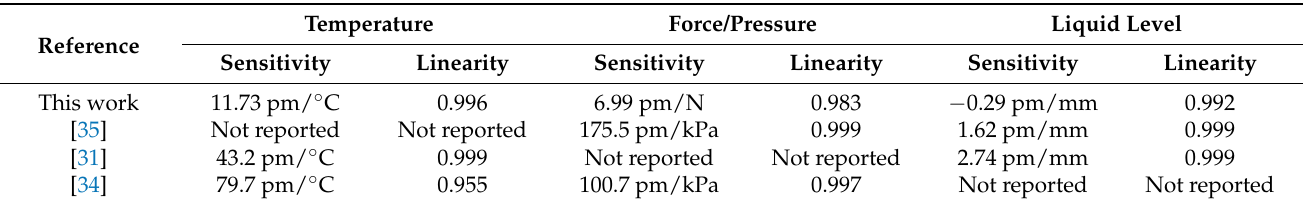
Table 1. Comparison between diaphragm-embedded FBG sensors for multiparameter